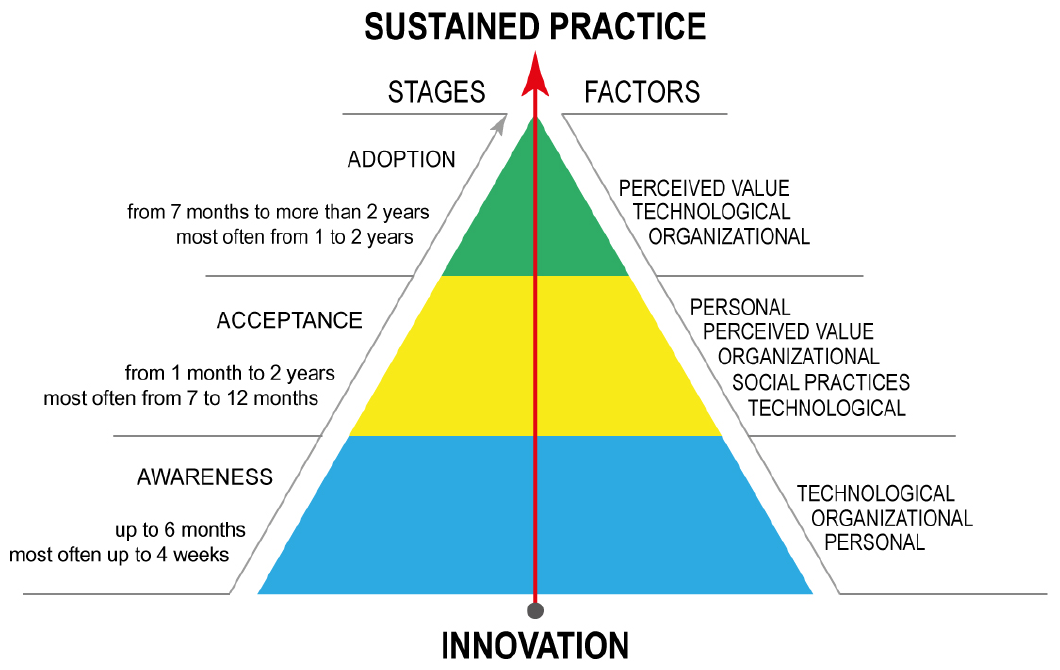
Figure 1. The IP stages and factors influencing the IP. Adapted from [26].